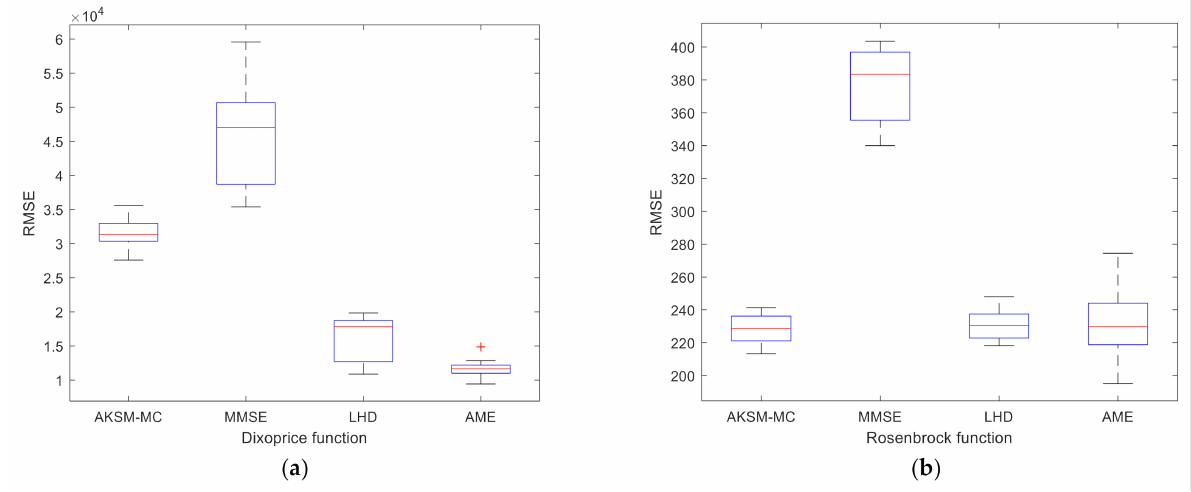
Figure 11. ( a ) Box plot of test results for DixonPrice function; ( b ) Box plot of test results for Rosenbrock function.